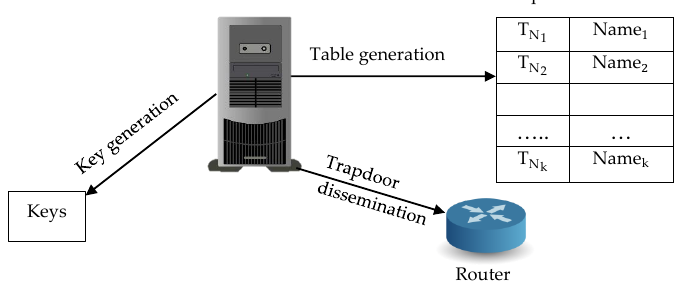
Figure 7. Producer initial